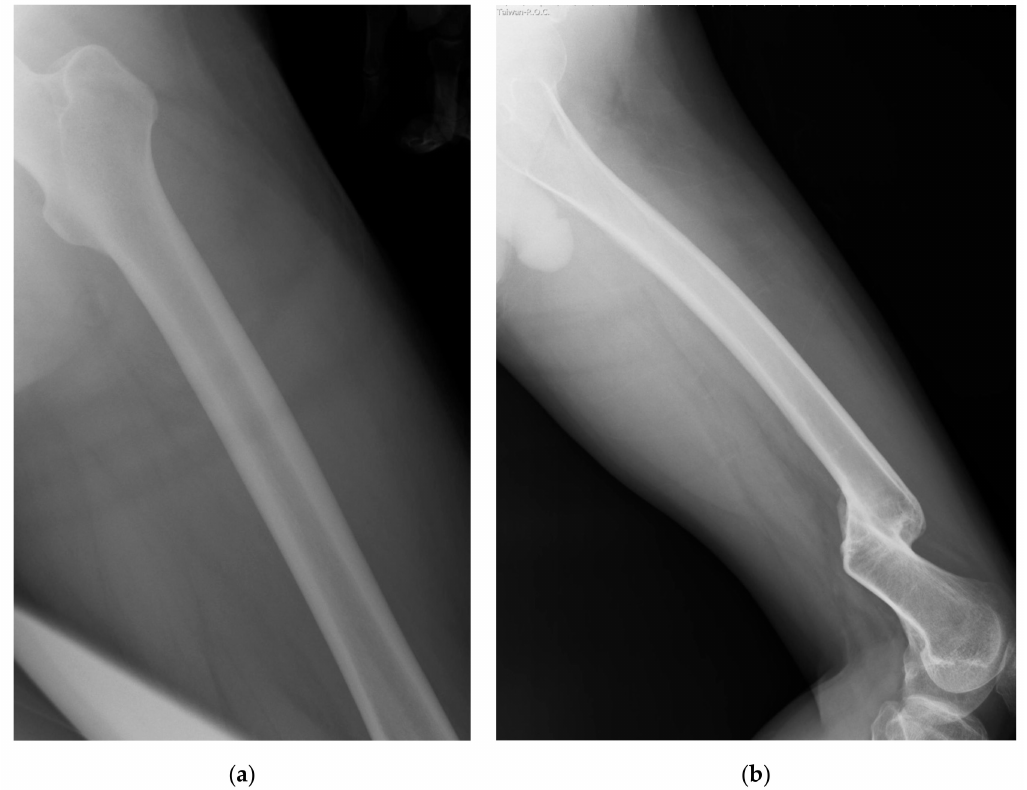
Figure 1. ( a ) Two examples of the excluded images: Note the whole length of femur was not included in the image; ( b ) Fracture of the femur with notable displacement is noted in the image.